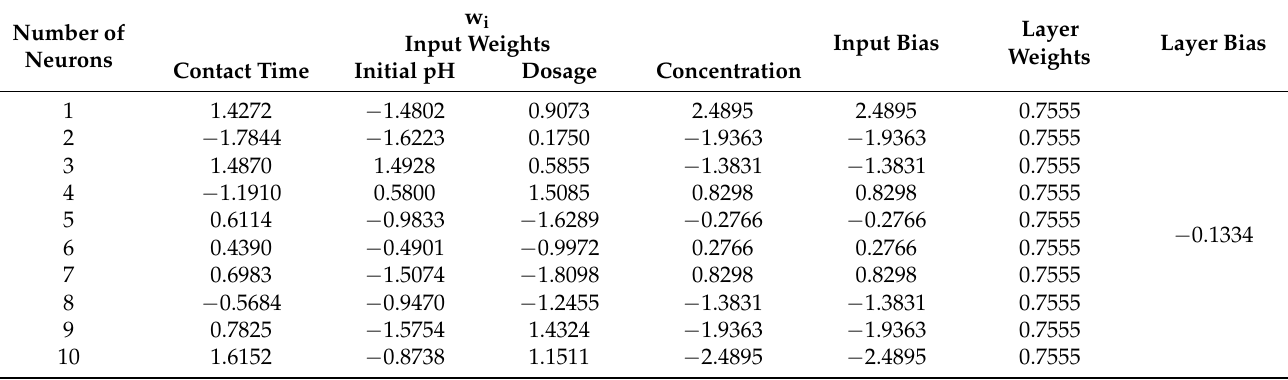
Figure 20. Mean square error (MSE) of the neurons in the BP-ANN model.